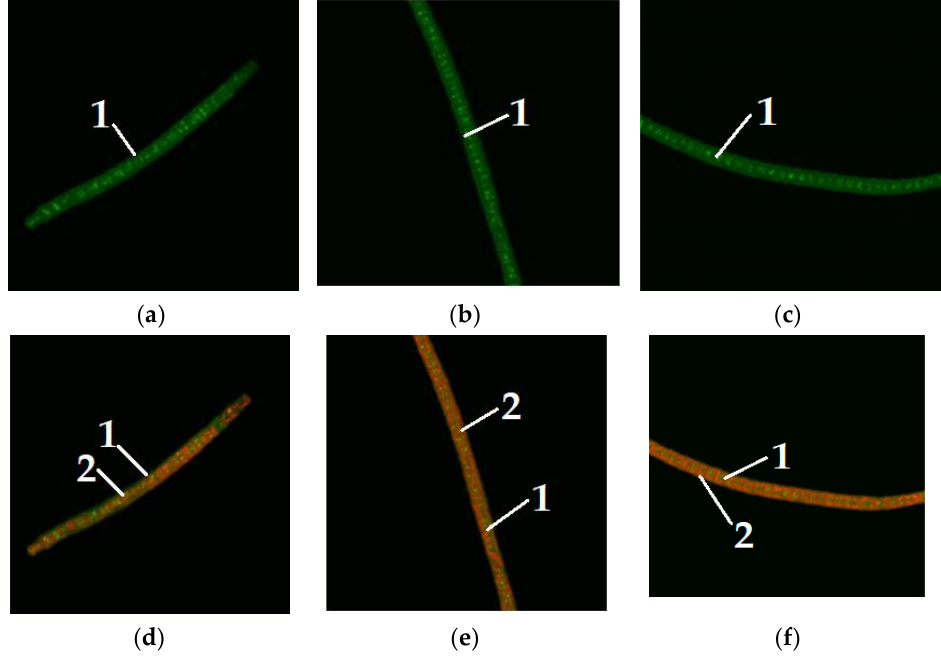
Figure 7. Microalgae Arthrospira platensis when fructose was added to the nutrient medium (1 – lipid droplet, 2 – chlorophyll): ( a – c ) visualization of lipids; ( d – f ) visualization of chlorophyll. (1—lipid droplet, 2—chlorophyll): ( a – c ) visualization of lipids; ( d – f ) visualization of